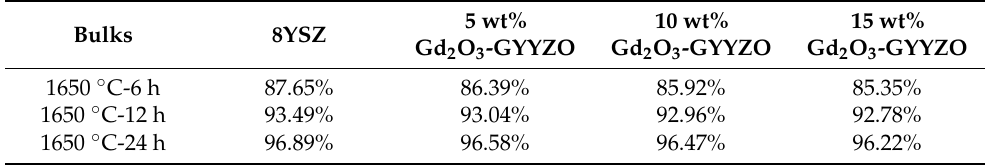
Table 5. The densification of the sintered bulks.